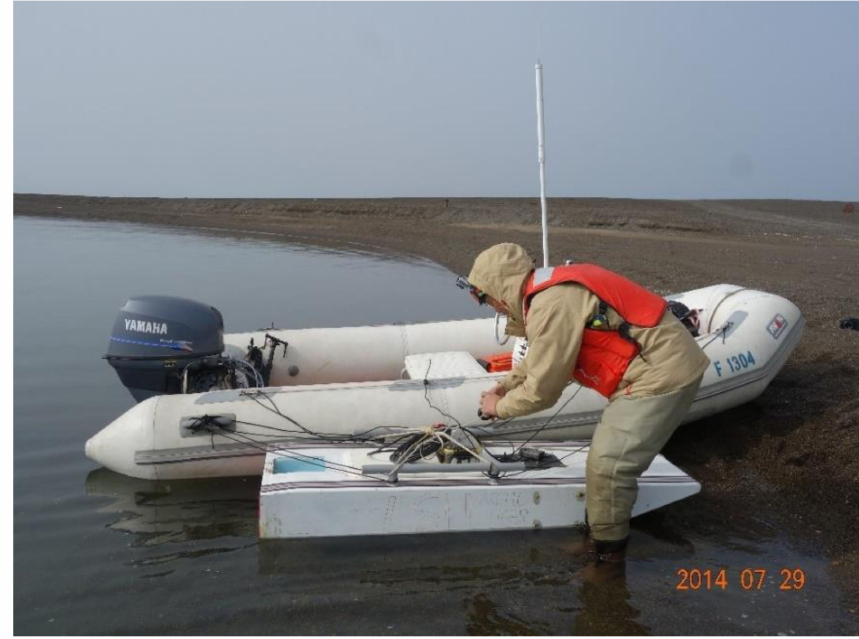
Figure 3. The inflatable vessel used to tow the fiberglass surface craft (in front of the inflatable vessel), which carried the M9